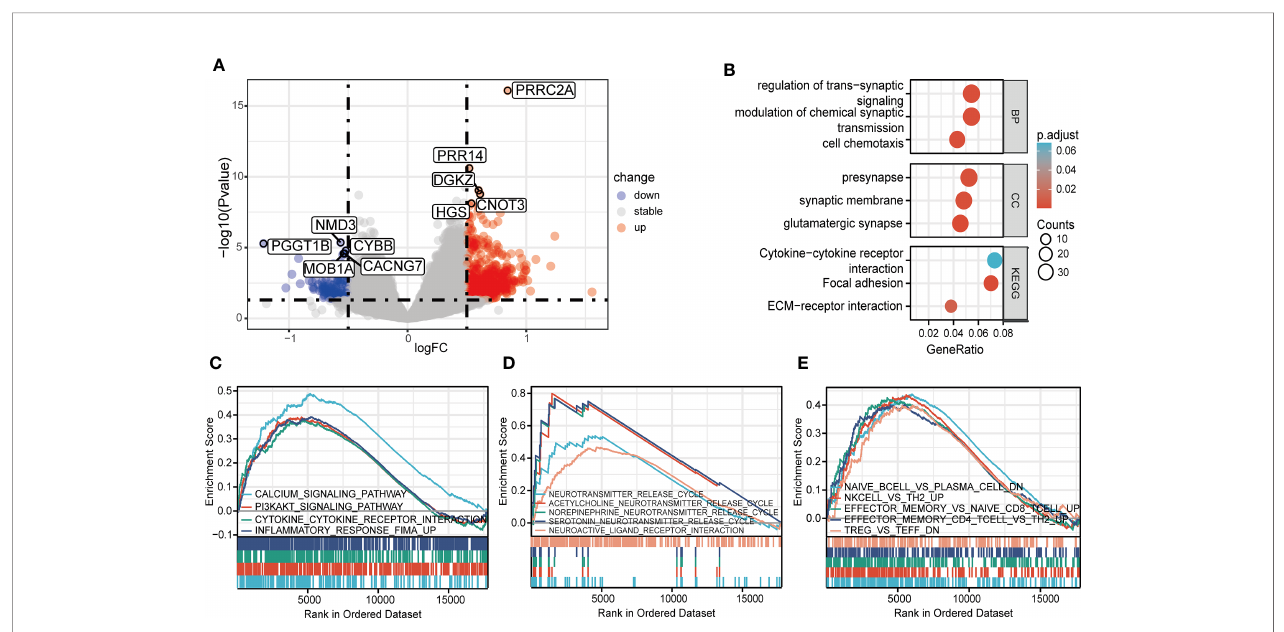
FIGURE 2 | The identi fi cation and functional enrichment of differentially expressed genes based on PRRC2A mRNA expression in type 1 diabetes. (A) Volcano plot of the differentially expressed genes (DEGs) between groups exhibiting high and low levels of PRRC2A mRNA. (B) Signi fi cantly enriched Gene Ontology (GO) and Kyoto Encyclopedia of Genes and Genomes (KEGG) pathway terms of PRRC2A associated DEGs. (C) Gene set enrichment analysis (GSEA) indicated that high expression level of PRRC2A was correlated with calcium signaling, PI3K/AKT signaling, cytokine-cytokine receptor interaction, and in fl ammatory response pathways. (D) GSEA indicated that high expression level of PRRC2A was correlated with neuroactive ligand-receptor interaction, and neurotransmitter (acetylcholine, norepinephrine, serotonin) release cycle pathways. (E) GSEA indicated that high expression level of PRRC2A was correlated with downregulation of Treg and Th2, and upregulation of effector memory CD4+ T, CD8+ T cells, NK cells, and plasma